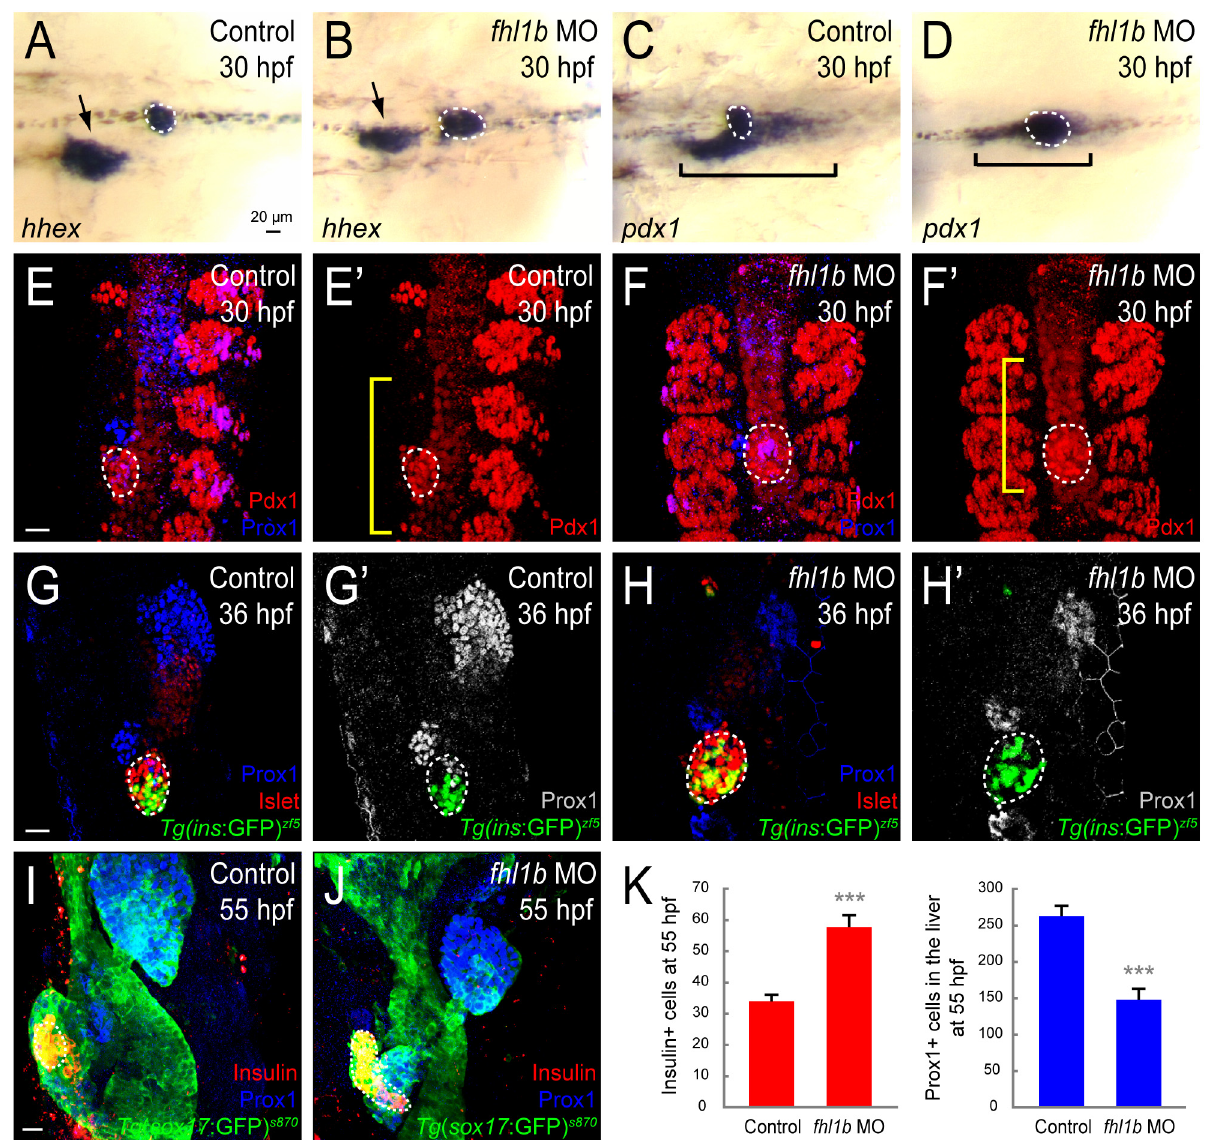
Fig 2. Loss of Fhl1b activity enhances induction of pancreatic cells and compromises liver specification. (A-D) Whole-mount in situ hybridization showing the expression of hhex (A and B) and pdx1 (C and D), comparing control embryos (A and C) and fhl1b morphants (B and D) at 30 hpf. hhex is expressed in the liver (black arrows) and the dorsal pancreatic bud (white dotted circles). pdx1 is expressed in the developing pancreas including the dorsal pancreatic bud (white dotted circles) and intestine (black brackets), but not in the liver. hhex expression was reduced in the liver of fhl1b morphants, while expanded in the dorsal pancreatic bud (B). pdx1 expression in the dorsal pancreatic bud was also expanded, while its expression in the intestinal bulb primordium appeared to be reduced in fhl1b morphants (D) compared to that of control embryos (C). (E – F 0 ) Confocal images of control embryos (E and E 0 ) and fhl1b morphants (F and F 0 ) at 30 hpf, stained for Pdx1 (red; expression in the dorsal pancreatic bud is outlined by white dotted circles) and Prox1 (blue). The somites are also Pdx1 positive. Compared to that of control embryos (E and E 0 ), in fhl1b morphants (F and F 0 ), the Pdx1 expression domain in the dorsal pancreatic bud was expanded, while the Prox1 expression domain was reduced. Note that the Pdx1 expression domain in the intestinal primordium (yellow brackets) appeared to be decreased in morphants (F ’ ). (G-H ’ ) Confocal images of Tg(ins : GFP) zf5 control embryos (G and G 0 ) and fhl1b morphants (H and H ’ ) at 36 hpf, stained for Islet (red; expression in the dorsal pancreatic bud is outlined by white dotted circles) and Prox1 (blue in G and H; grey in G ’ and H ’ ). In fhl1b morphants (H and H ’ ), the Prox1 expression domain was greatly reduced, whereas the number of Tg(ins :GFP ) zf5 - and Islet-expressing cells was increased. (I and J) Confocal images of Tg(sox17 : GFP) s870 control embryos (I) and fhl1b morphants (J) at 55 hpf, stained for Insulin (red; outlined by white dotted circles) and Prox1 (blue). fhl1b morphants (J) continuously exhibited an enlarged Insulin-expressing β -cell population with a reduced number of Prox1-positive cells in the liver. (K) Quantification of the number (mean ± SD) of Insulin-positive cells in the pancreas (red) and Prox1-positive cells in the liver (blue) at 55 hpf. 33.9 ± 2.1 cells were Insulin-positive in control embryos, whereas 57.8 ± 3.6 cells were Insulin-positive in fhl1b morphants. 148.0 ± 15.2 cells expressed Prox1 in fhl1b morphants, while 262.7 ± 14.0 cells were Prox1-positive in control embryos. Cells in 20 planes of confocal images from 5 individual